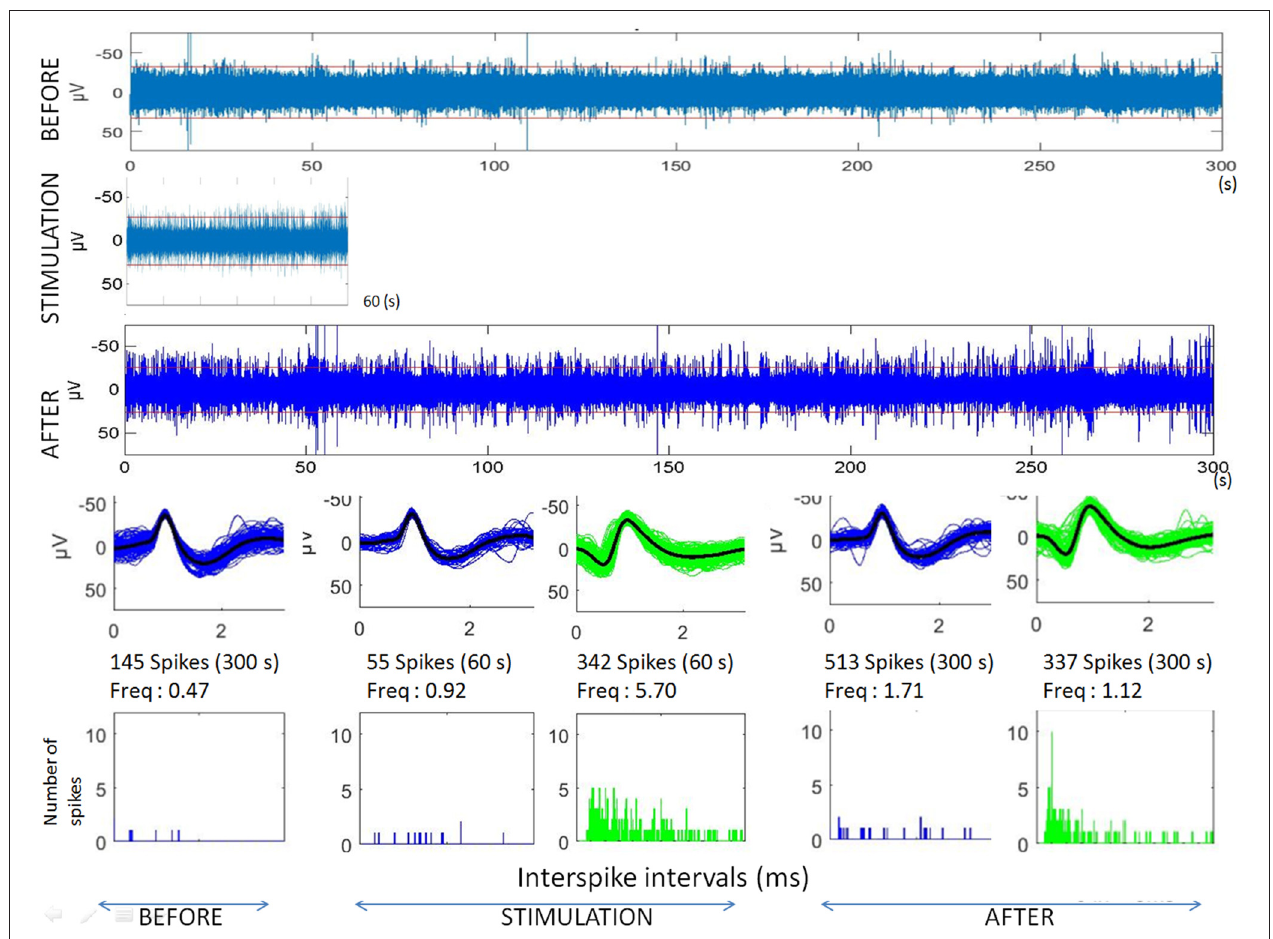
FIGURE 3 | Analyses of microstimulation within a cortical dysplagia (patient D1, 1 Hz). Top: raw microelectrode recordings before, during and after microstimulation; [150–3000Hz]). Middle: spike waveforms obtained with clustering of microelectrode recordings (with number of spikes, duration of the recordings, frequencies of spike occurrences—Freq—and their standard deviations). Bottom: interspike interval histograms (ordinate number of times that the delay between two consecutive spikes is within the category given in abscissa, with categories of 1 ms).